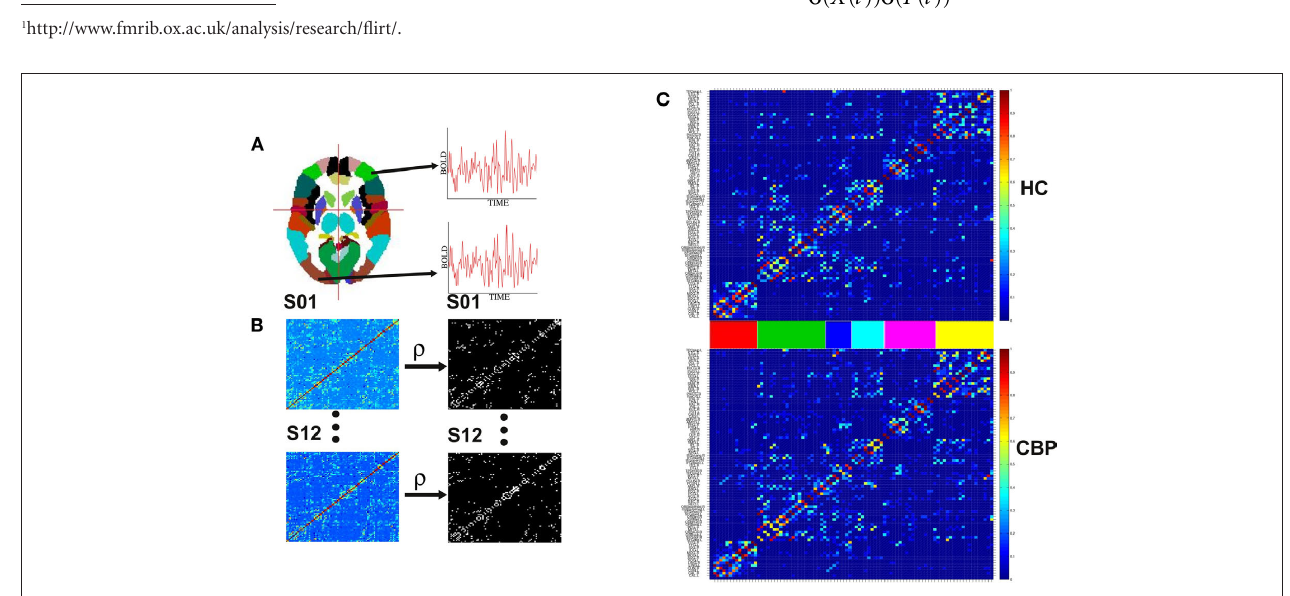
Figure 1 | Steps involved in the construction of brain correlation networks. (A) Average BOLD activity time series for each of the 90 anatomical regions defined in (Tzourio-Mazoyer et al., 2002) are extracted. (B) Partial correlation matrices (Eq. 1) for each of the twelve subjects in each group (left) and adjacency matrices (right) with 1 if two regions have a correlation larger